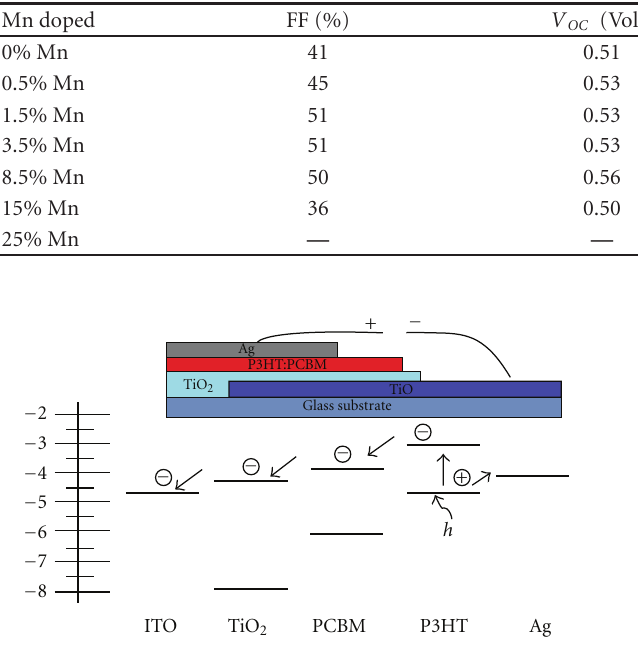
Figure 7: Schematic representation of the energy levels in our solar cell design (inset: the proposed solar cell